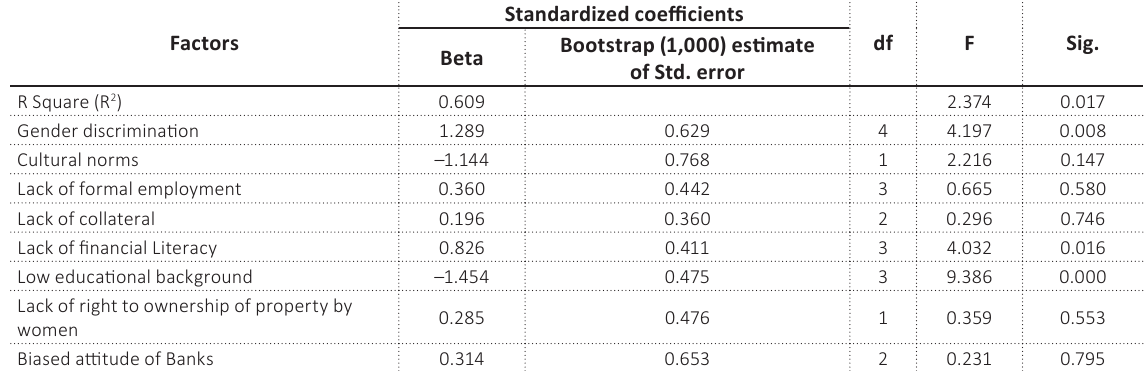
Table 4. CAT-REG test on the factors militating against women trying to access building credits from banks Standardized Factors